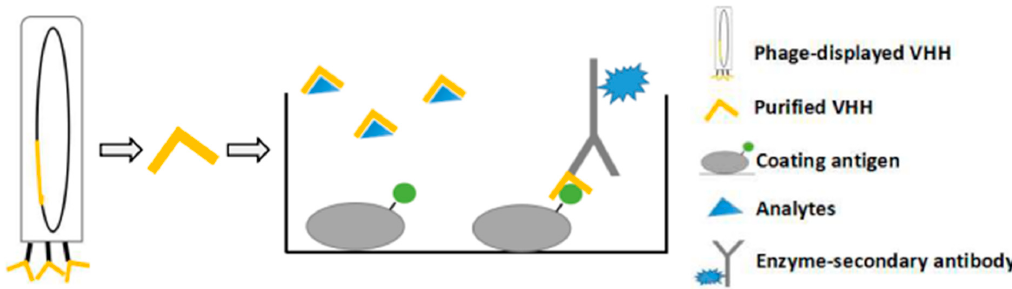
Figure 4. VHH production and anti-hapten VHH-based immunoassay. Coating antigen and